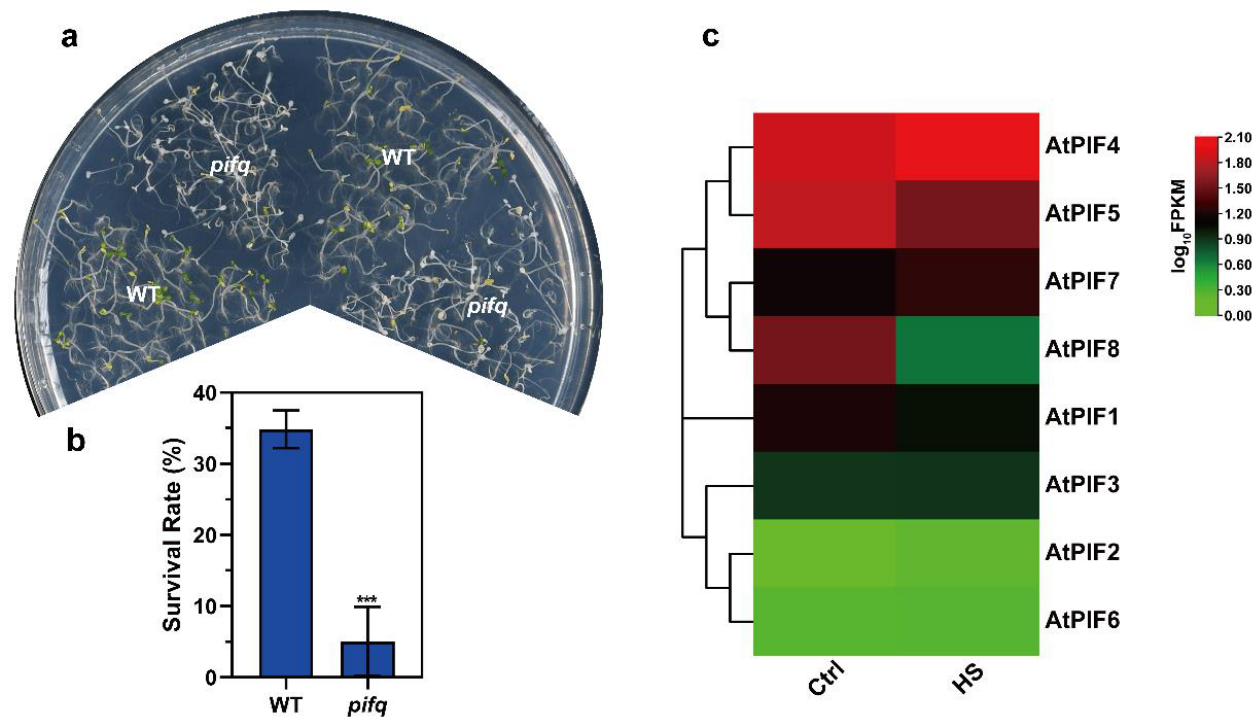
Figure 2. The pifq (pif1/3/4/5) mutant exhibits reduced thermotolerance. ( a ) Thermotolerance phe- notypes of 4-day-old pifq seedlings grown in darkness were treated at 45 ◦ C for 1 h and were allowed to recover at 22 ◦ C for 3 d under long day conditions (16 h light/8 h darkness). ( b ) Quantification of the survival rates as indicated in ( a ). Values are the means ± SD of three independent biological replicates. Statistical differences calculated using Student’s t -test are shown. Asterisks indicate the significant differences (*** p < 0.001). ( c ) Heat maps of the expression of the PIF genes under heat stress. The FPKM values of each gene are normalized by log10.